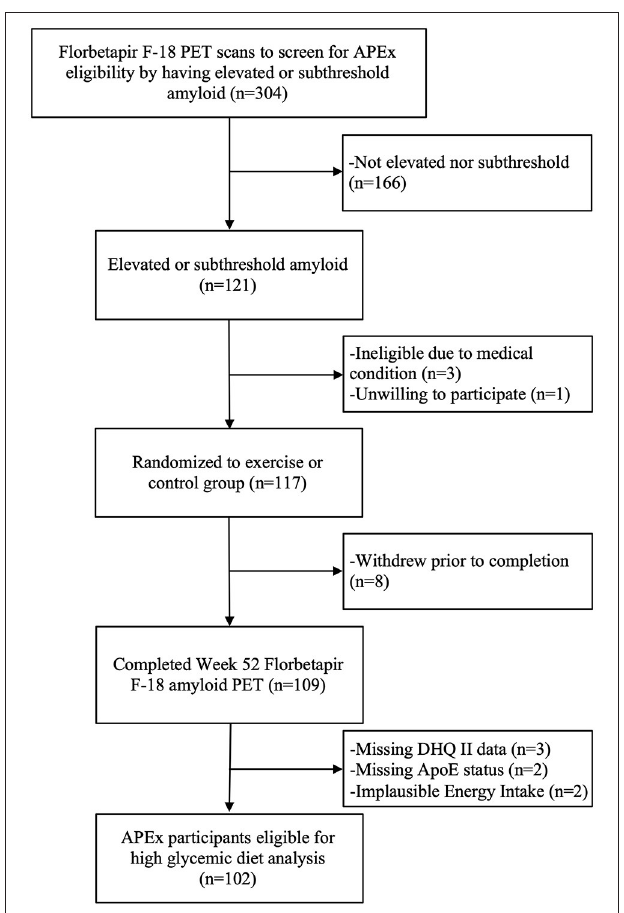
FIGURE 1 | Diagram of the flow of participants included in this analysis.